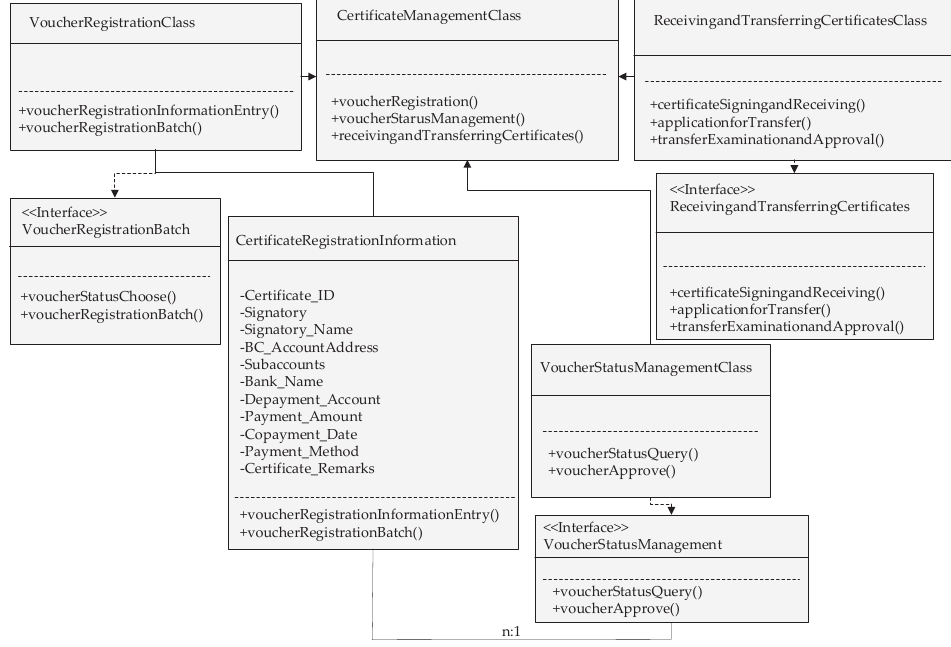
Figure 8. Class diagram of certificate management module.